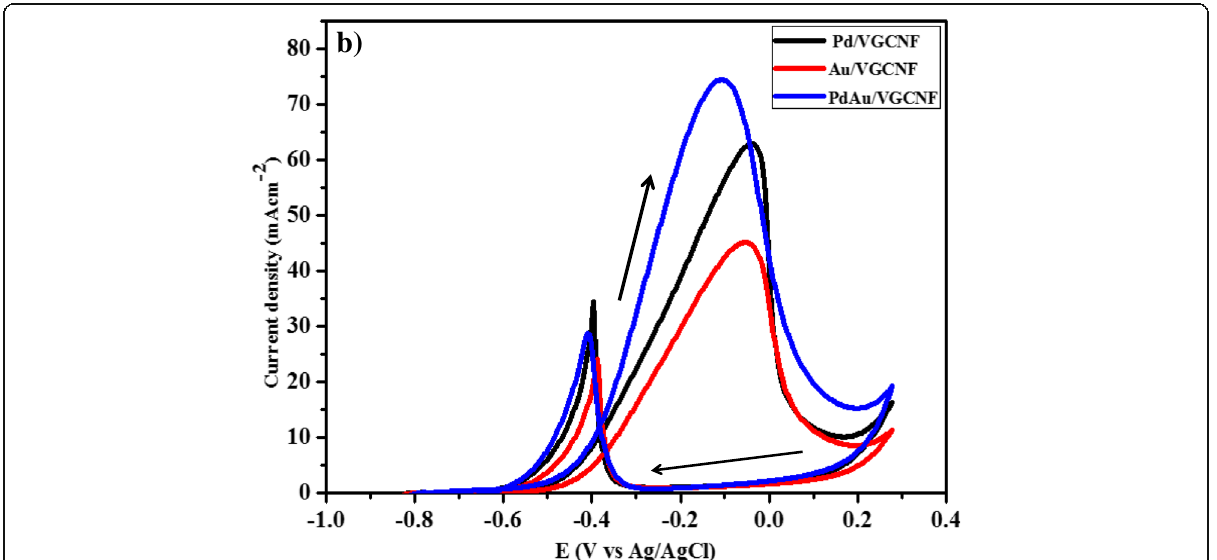
Fig. 6 Cyclic voltammogram for Pd/VGCNF, Au/VGCNF, and PdAu/VGCNF in 0.5 M glycerol + 0.5 M NaOH